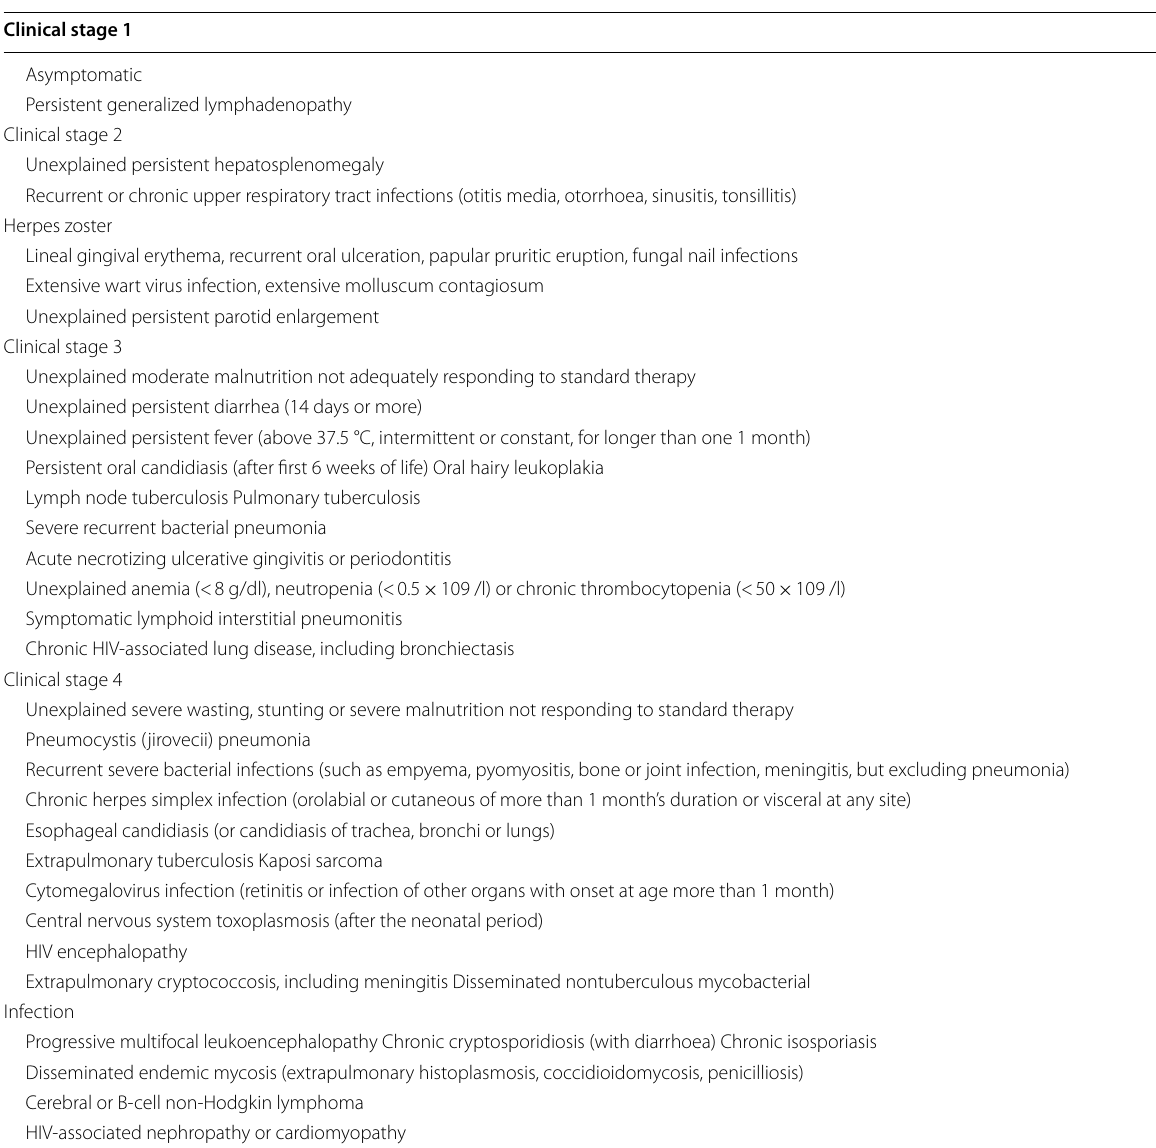
Table 1 Table showing the clinical staging of HIV infection in children according to the World Health Organisation (WHO) (Adapted from WHO